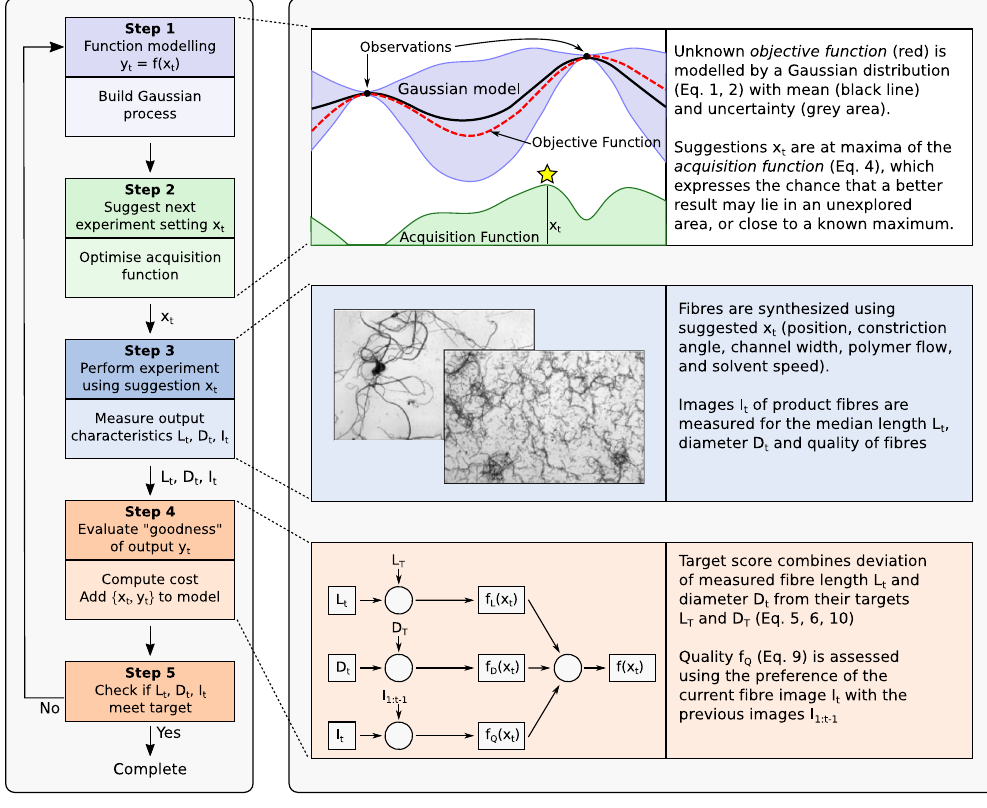
Figure 2. Adaptive Experimental Optimisation. Five steps include: (1) modelling the unknown function, (2) recommending the next experimental setting, (3) manufacturing and measuring short polymer fibers, (4) evaluating the product utility, and (5) checking target. These steps repeat until the target is achieved, or the process is